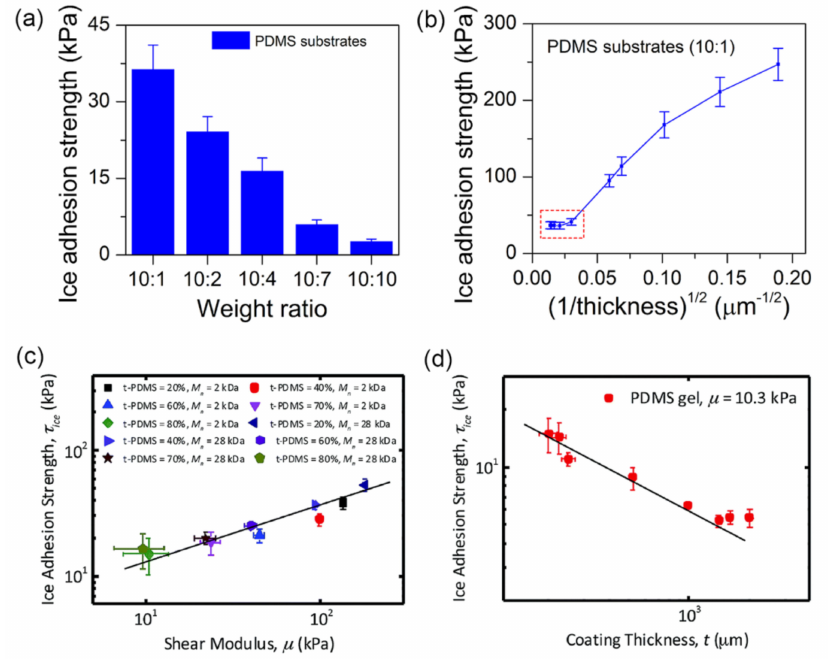
Figure 4. Ice adhesion strength at − 18 ◦ C plotted against ( a ) PDMS substrates and sandwich-like PDMS sponges with the weight ratio of prepolymer and curing agent ranging from 10:1 to 10:10; ( b ) correlation between ice adhesion strength and PDMS coating thickness in ( a ); ( c ) correlation between ice adhesion strength and shear modulus of PDMS gels; and ( d ) correlation between ice adhesion strength and coating thickness of PDMS gels in ( c ). Panel ( a , b ) reproduced with permission from Ref. [2], Copyright 2018, the Royal Society of Chemistry; panel ( c , d ) reproduced with permission from Ref. [41], Copyright 2016, the Royal Society of